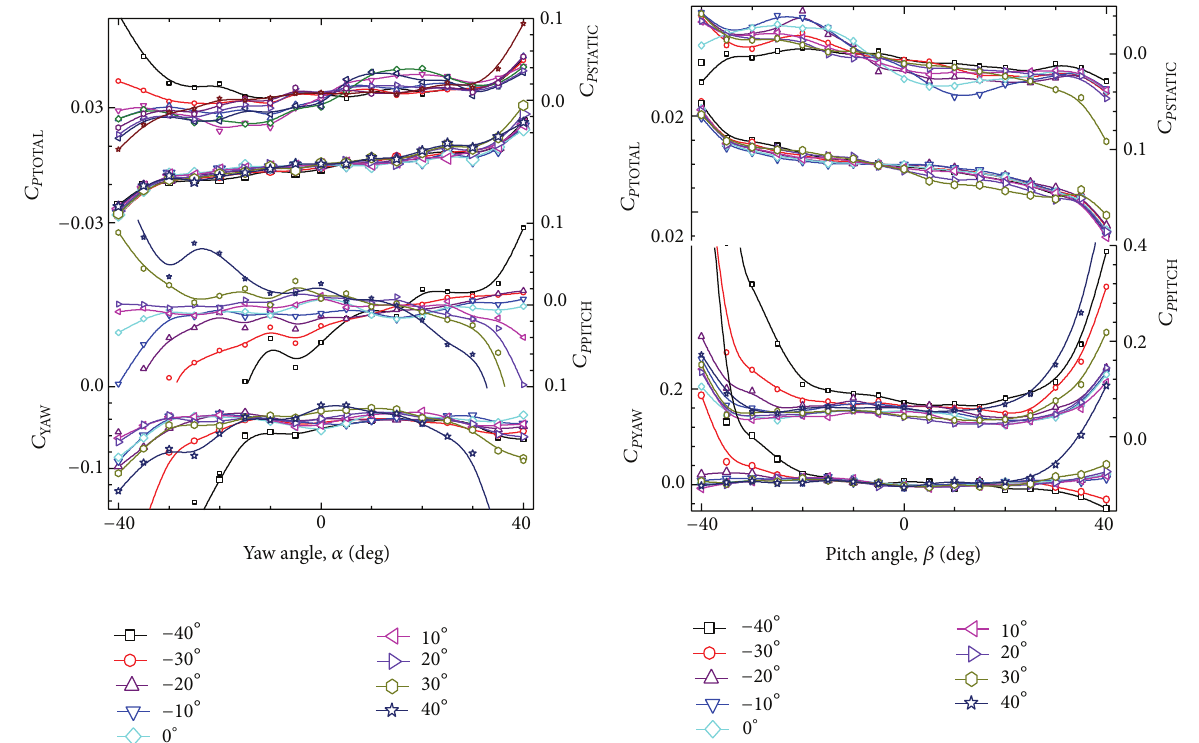
Figure 6: Sensitivity curves of calibration